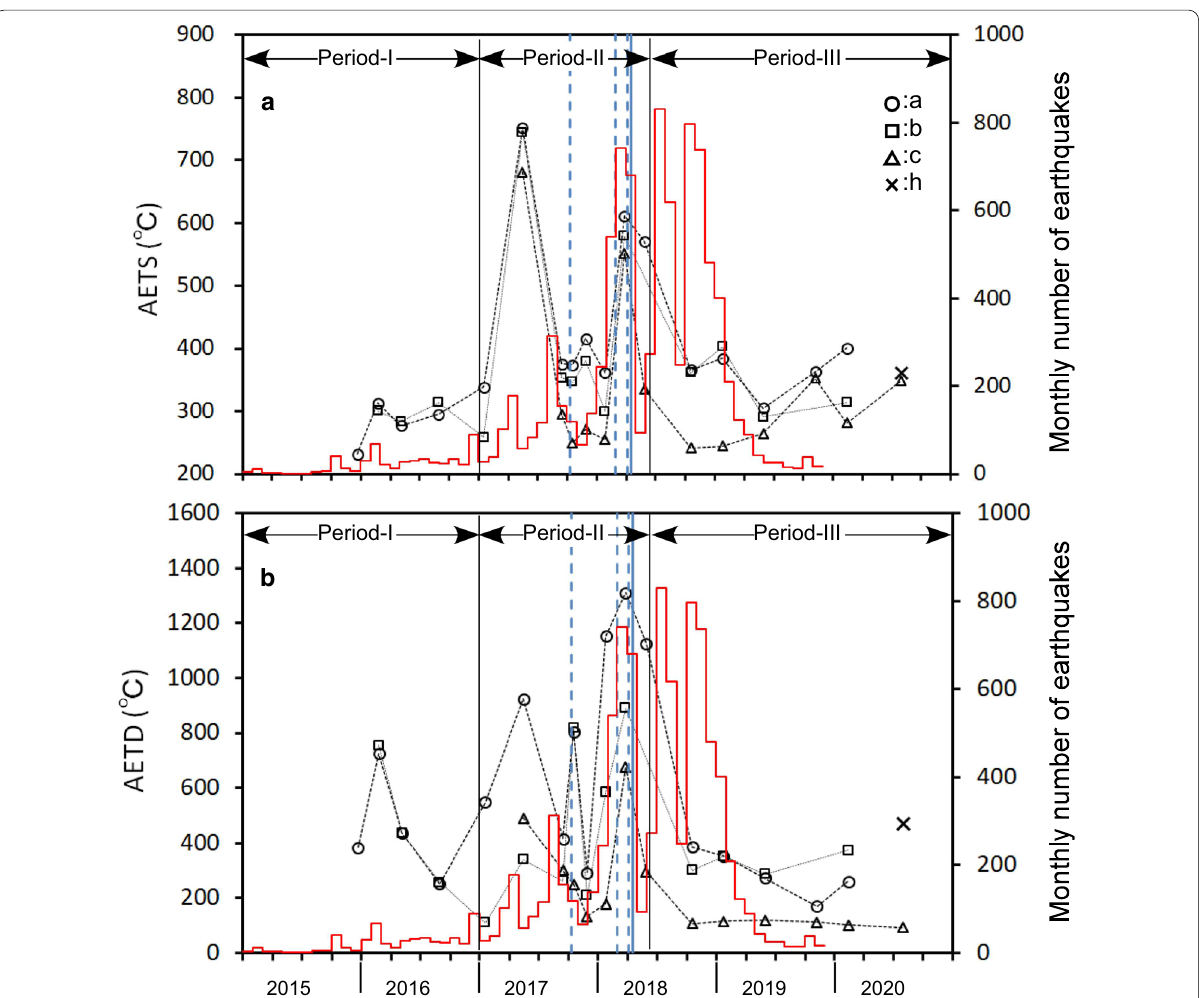
Fig. 6 a Changes in the apparent equilibrium temperature (AETS) defined for the reaction involving SO 2 , H 2 , H 2 S and H 2 O. b Changes in the apparent equilibrium temperature (AETD) defined for the deuterium exchange reaction between H 2 O and H 2 . Red histogram and vertical lines have the same meaning as in Fig.